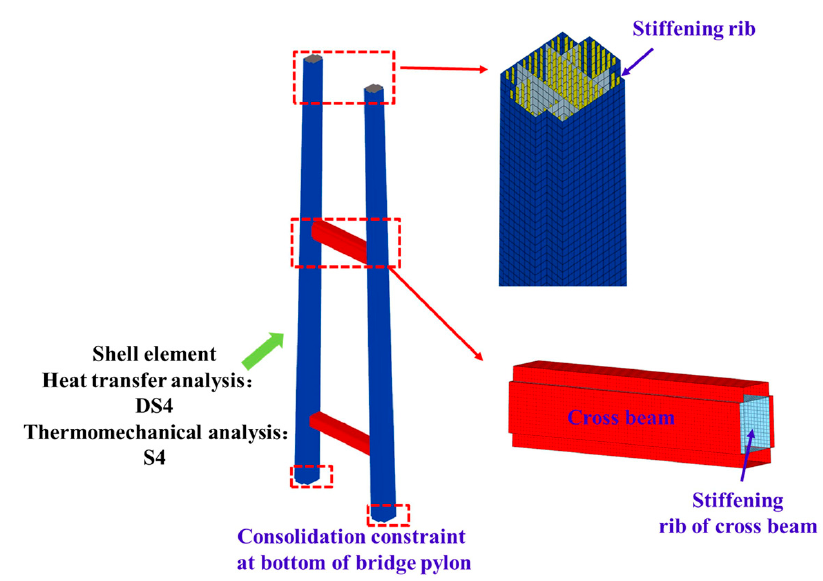
Figure 6. H-type ultra-high steel bridge pylon model. Table 1. Thermal Parameter.